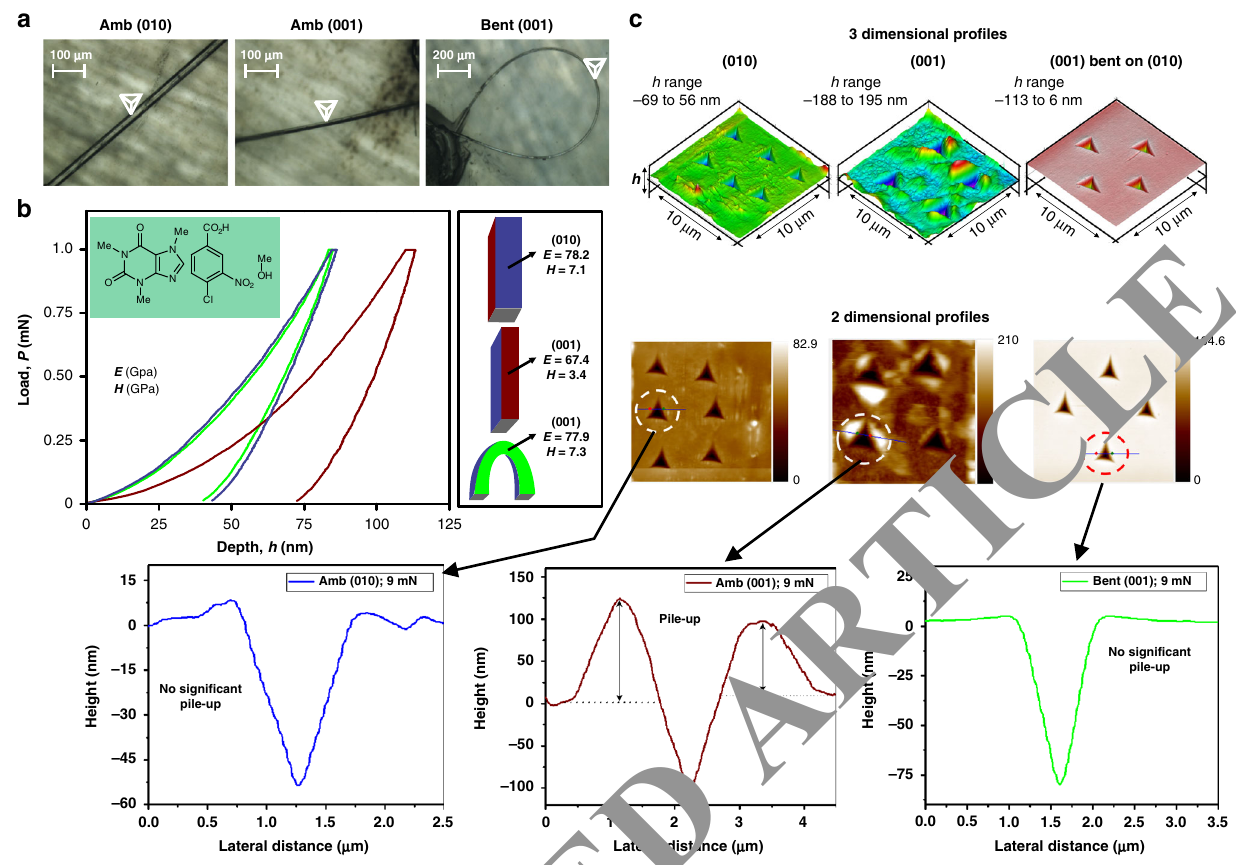
Fig. 1 Mechanical properties of ambient and bent crystals obtained by nanoindentation. a Optical images of (010) and (001) of straight crystals and (001) face of the crystal loop bent on (010) and schematic indenter tip (white cone). b Load – depth ( P – h ) curves obtained on an ambient cocrystal from indentation on (010) (blue), (001) (brown) face and a bent crystal, on (001) (light green) face and their corresponding highest E and H values. c In situscanning probe 3D and 2D microscopic images of impressions at 9 mN load with corresponding height pro fi les of impressions elucidating pile-up characteristics of different faces of ambient and bent crystals